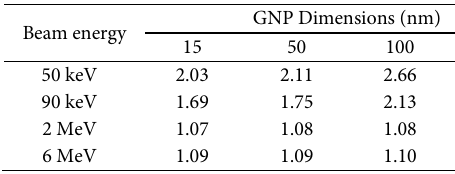
Table 1. Average DEFs for different energies in the presence of GNPs with different sizes GNP Dimensions (nm) Beam energy